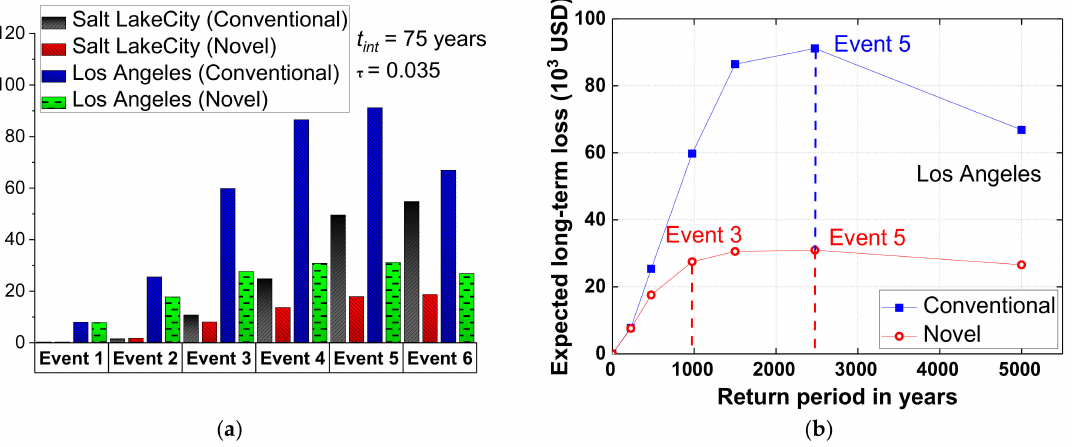
Figure 15. Expected long-term loss of bridges ( a ) under six events ( b ) with 50, 475, 2475, and 5000-year return